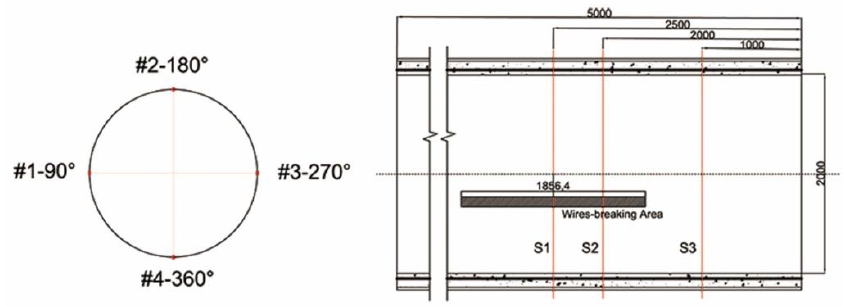
Figure 11. Location of measuring sections; dimension: mm.